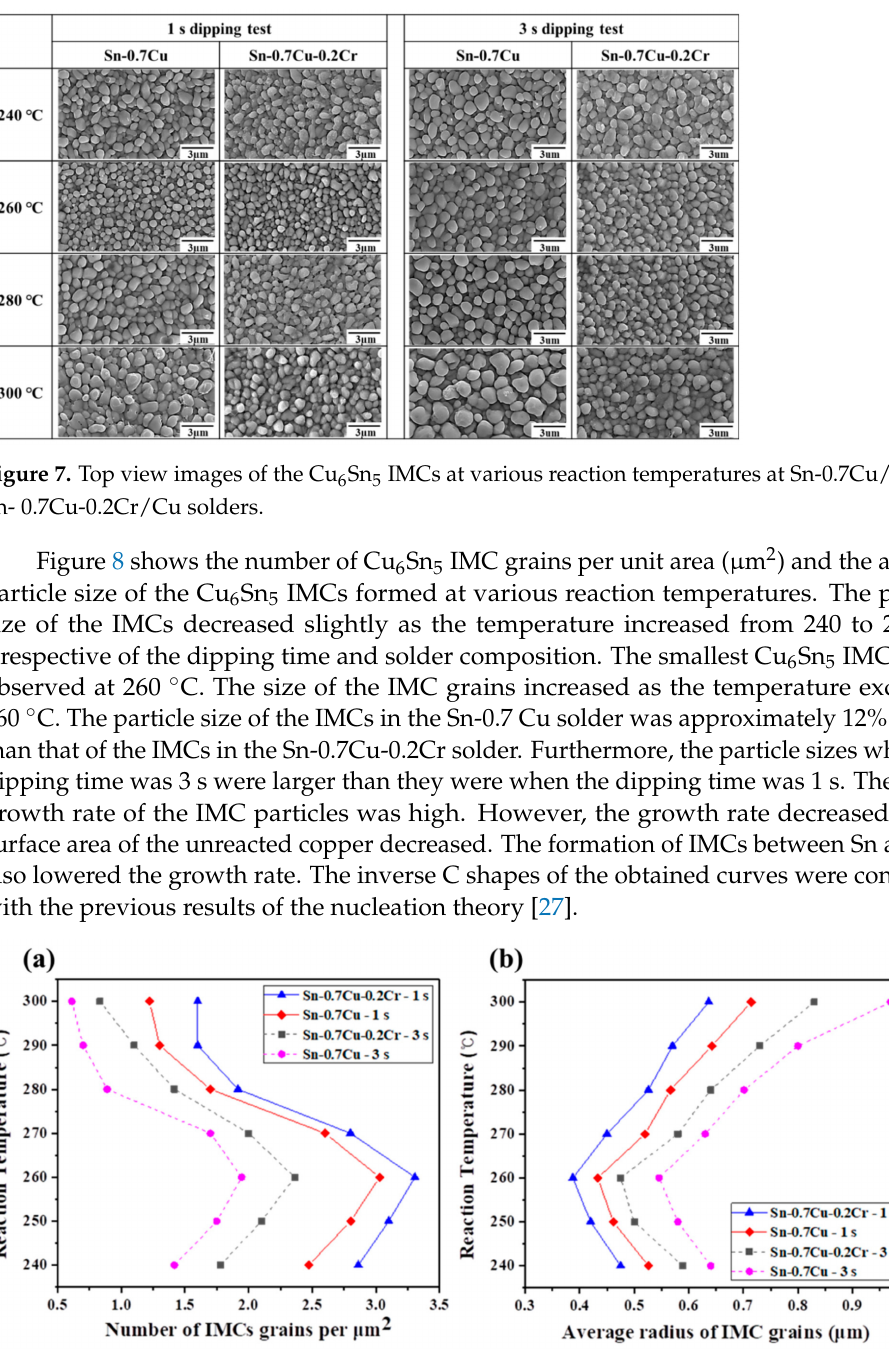
Figure 8. ( a ) Number of Cu 6 Sn 5 IMC grains per unit area ( µ m 2 ) and the ( b ) average radius of the Cu 6 Sn 5 IMC grains, at various reaction